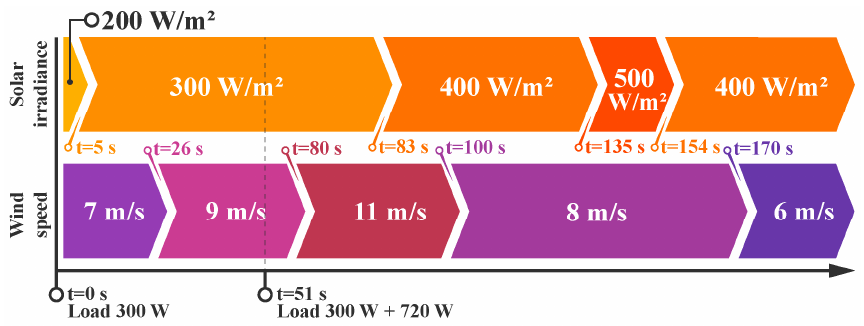
Figure 17. Timeline of events in the grid-tie operation experiment.